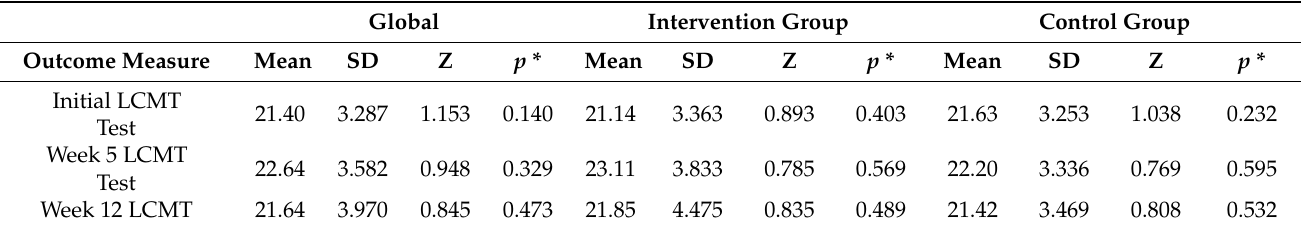
Table 2. Normality